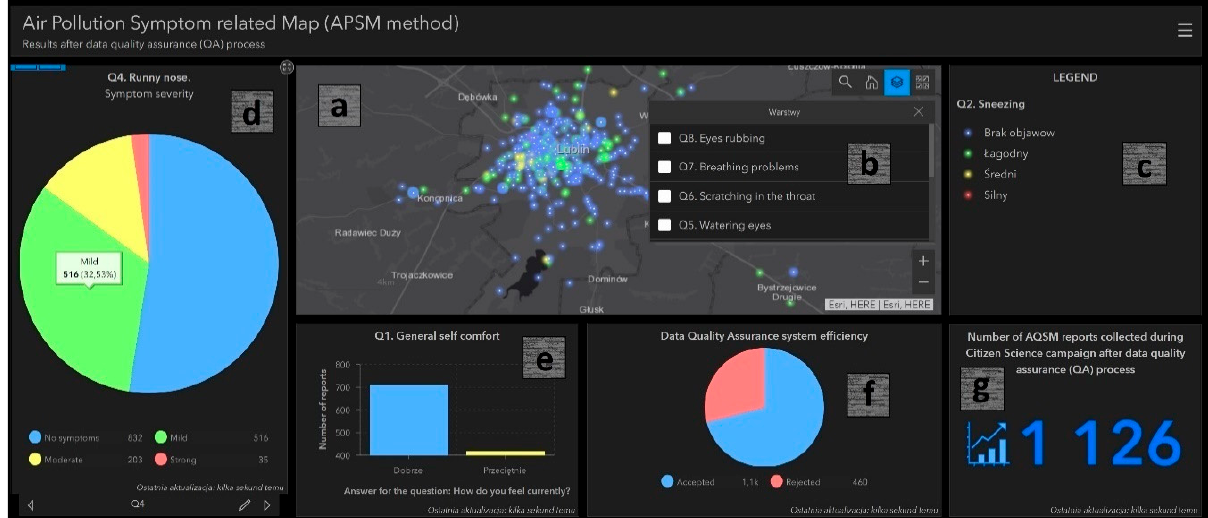
Figure 5. Web mapping dashboard app presenting results of QA-checked data using QAs 8 : ( a ) map, ( b ) layer list, ( c ) legend, ( d ) pie chart of citizen symptom severity, ( e ) bar chart of citizen general comfort, ( f ) pie chart of QA system robustness, and ( g ) indicator of QA-checked reports. Table 7. QA s8 impact on the percentage of surveys with reported air-pollution-related symptoms.